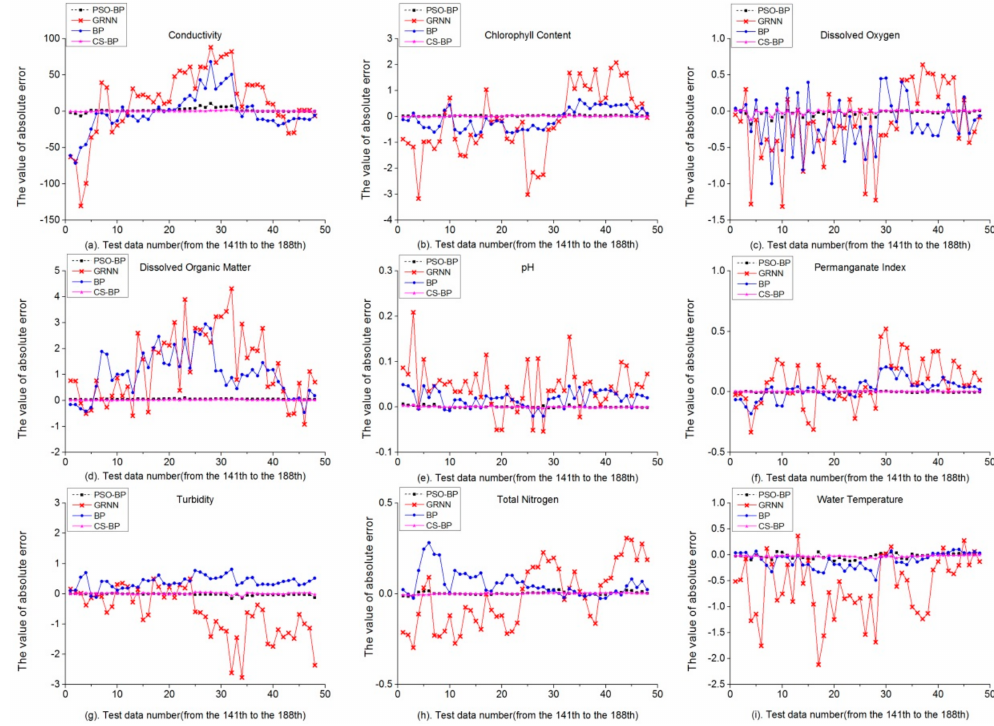
Figure 8. The absolute errors of water quality indicators of four models of part B in Scenario